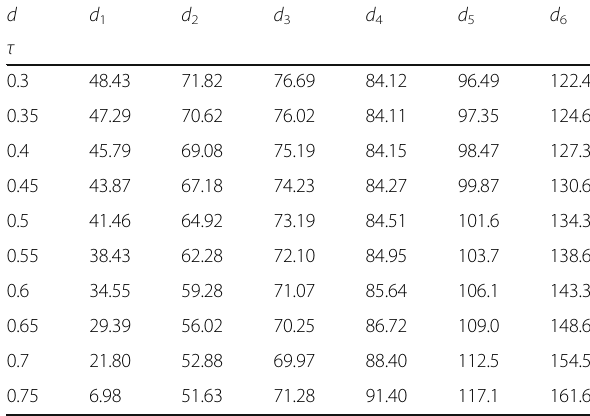
Table 5 The unequal distance of nodes (MQAM)